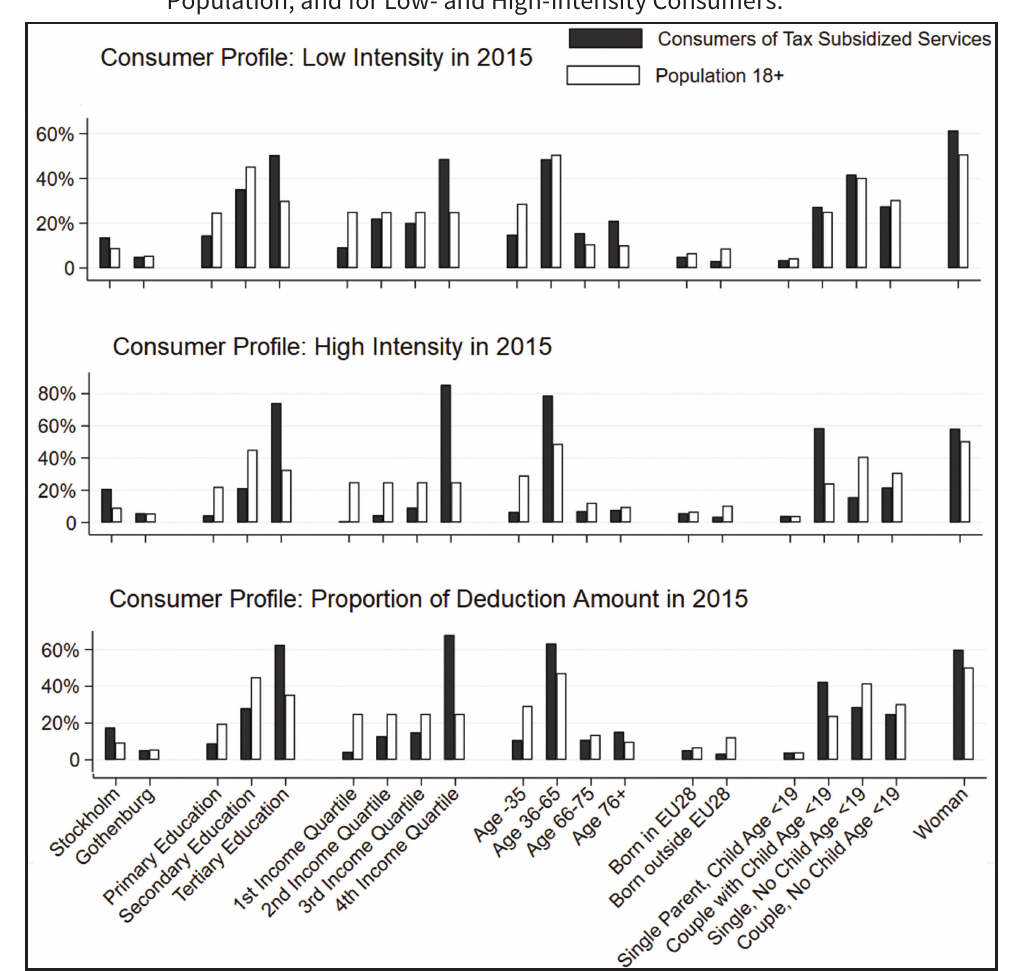
Figure W3 Demographic Profile of Consumers of Subsidized Services Compared to the Population, and for Low- and High-Intensity